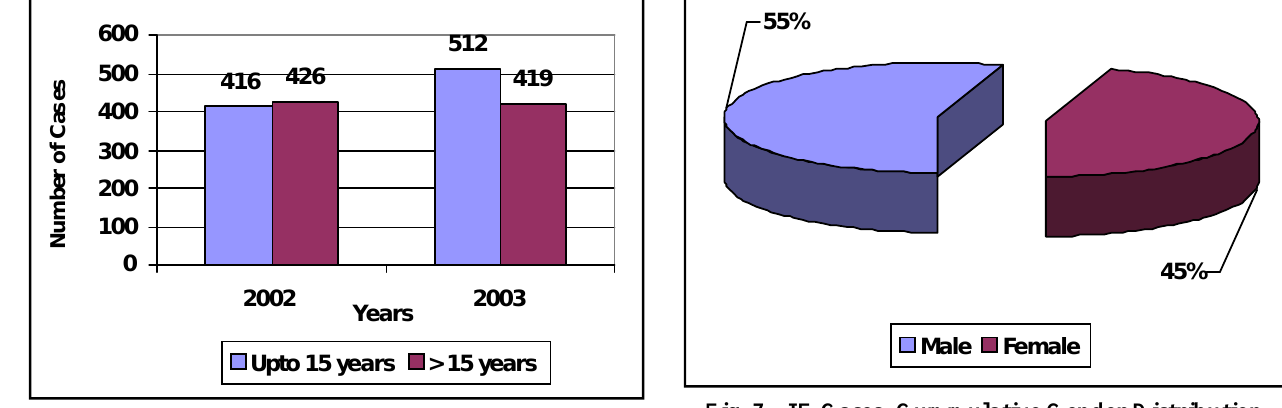
Fig. 4 : JE Cases: Age Distribution, 2002 and 2003